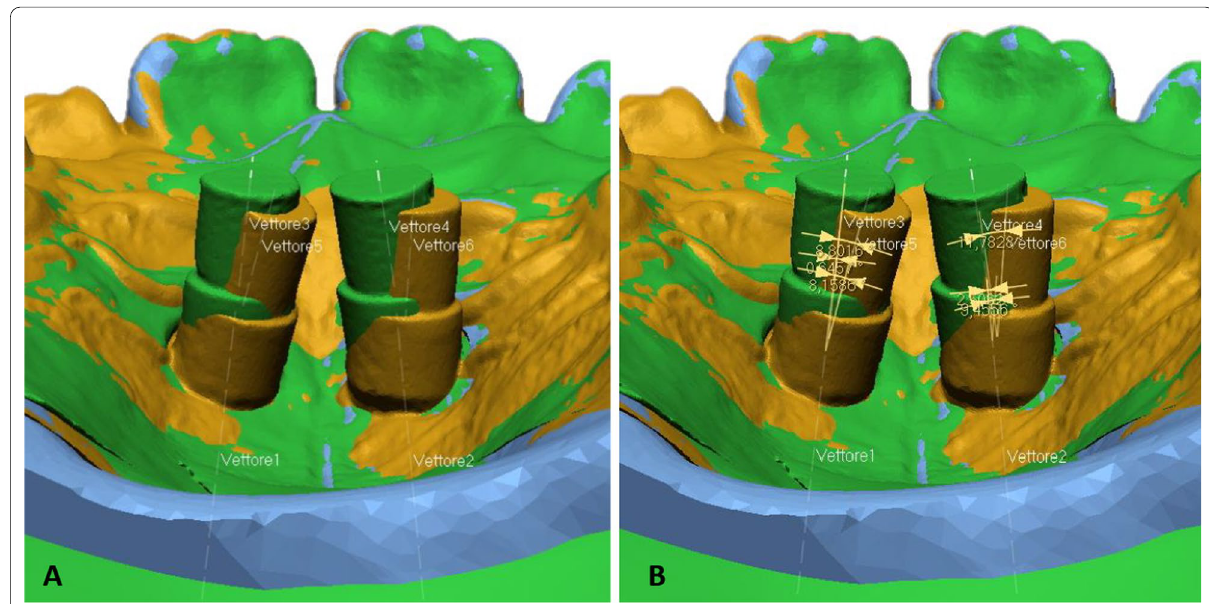
Fig. 3 A view of all three files is “switched on” once all the axes are identified; B angular deviations between vectors are calculated